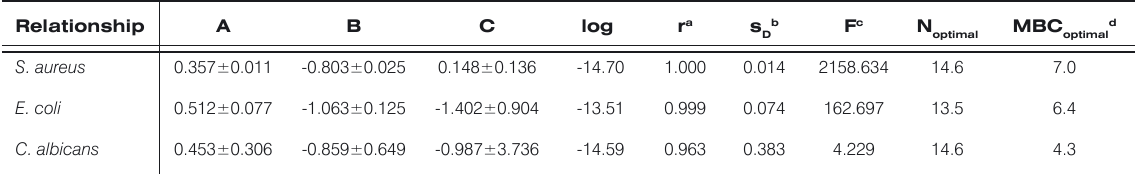
Table 4. Regression coefficients for bilinear relationship between microbicidal activity and structure for (2S)-N-alkyl-N,N-dimethyl-(1-hydroxy-3- phenylpropyl)-2-ammonium